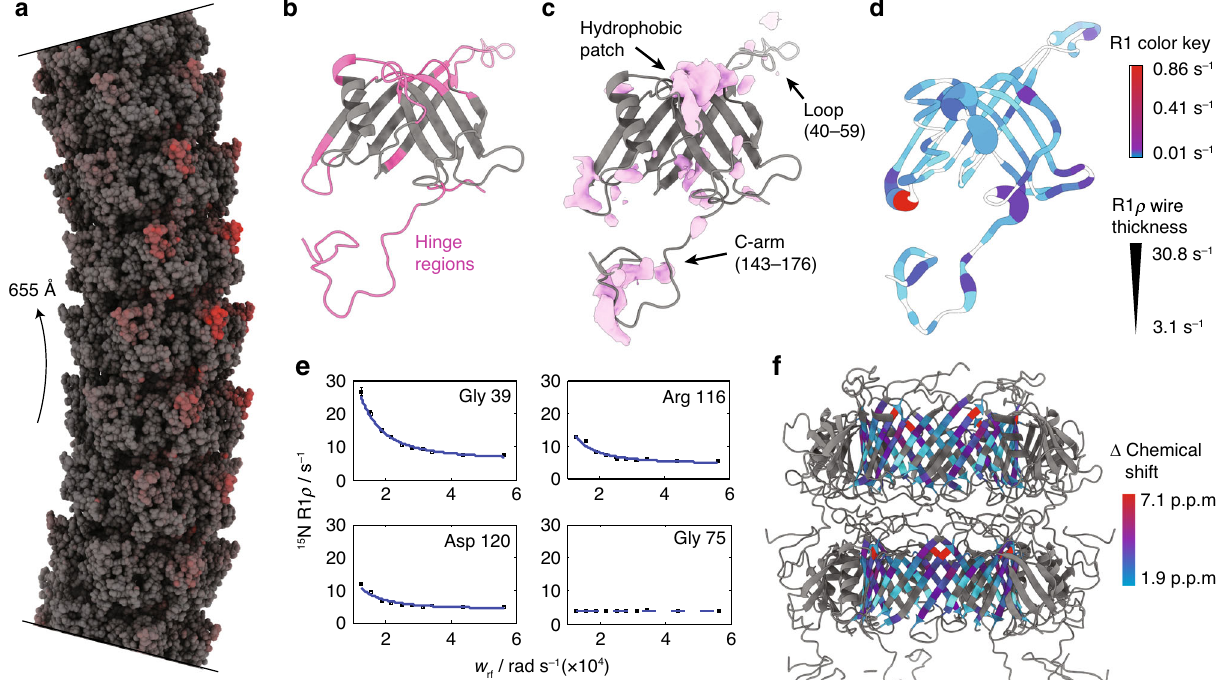
Fig. 4 Bending of the tail tube is mediated by fl exible hinge regions. a Model of a bent SPP1 tail tube with a curvature radius of 655 Å (as indicated by the arrow). The model is based on the structure of straight tubes and 2D class averages of bent tubes. Most structural changes are found on the outside of the curve (red) which implies that the bending process is mediated by stretching. b Regions that act as hinges during bending of the tube are colored in pink. c Variances in the cryo-EM map (pink) match the hinge regions. d Also, hinge regions are associated with highest 15 N R 1 (color key) and R 1 ρ (thickness of wire) relaxation rates. White coloring represents missing values. e Decaying relaxation dispersion pro fi les indicate the presence of slow motions. f Relaxation dispersion pro fi les of the inner β -barrel can be fi tted in a correlated manner to a two-state exchange process. Smallest chemical shift changes correlate with middle regions of the β -barrel which are furthest away from the hinge regions (color key). The direction of the tail structure is baseplate upwards. Source data are provided as a Source Data fi